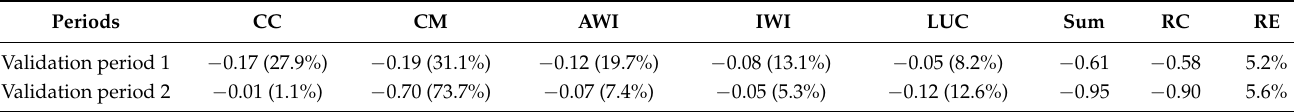
Table 9. Contribution rate calculations for various factors based on